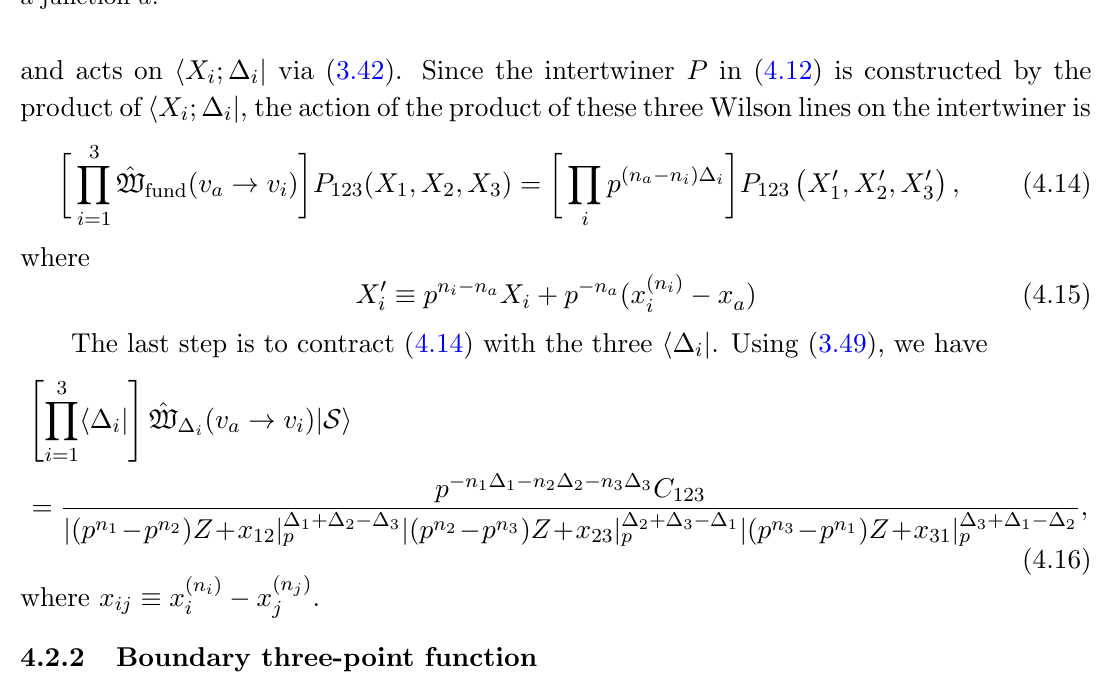
Figure 4 . A network of three Wilson lines connecting three boundary points x 1 ; 2 ; 3 and joining at a junction a